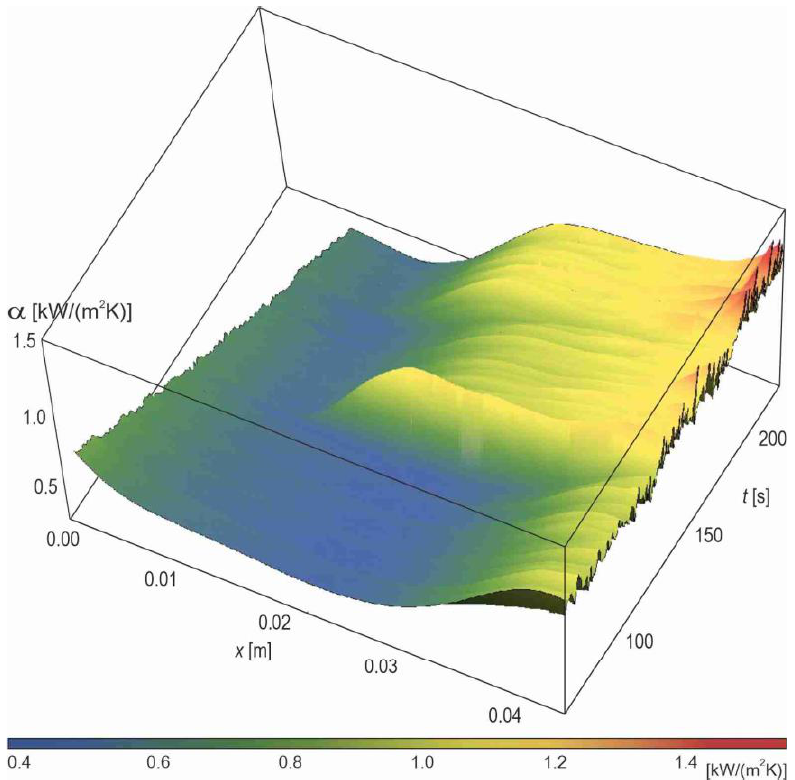
Figure 9. The heat transfer coefficient as a function of distance from the mini-channel inlet and time; the experimental parameters shown in Table 1.